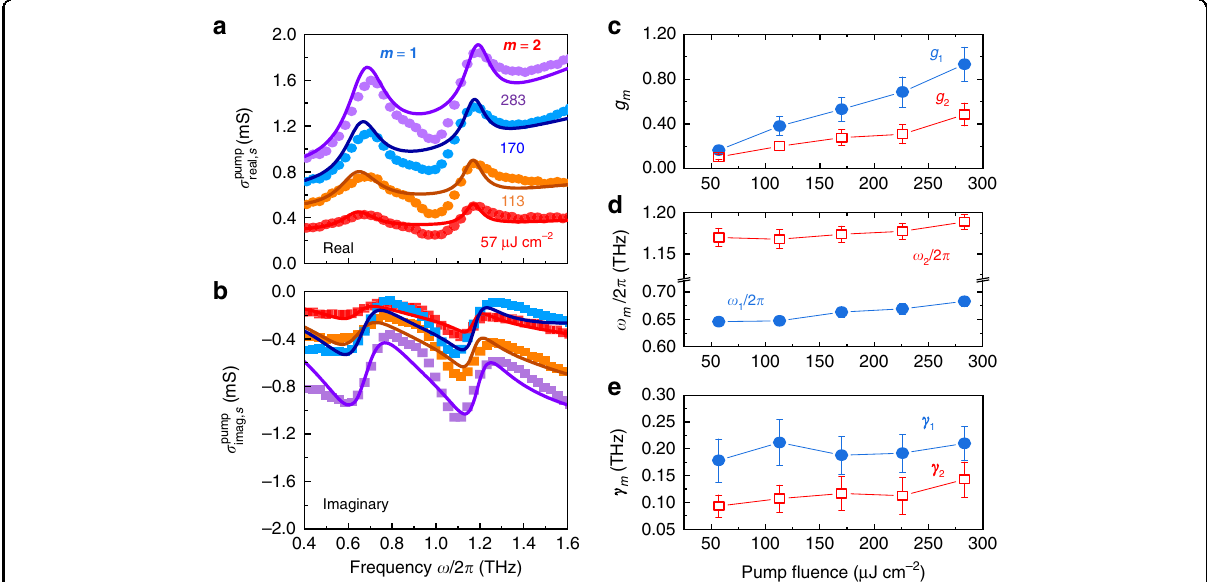
Fig. 3 Pump fl uence-dependent THz photoconductivity spectra for MAPbI 3 polycrystalline grains. Extracted a real and b imaginary parts of THz photoconductivity spectra of MAPbI 3 polycrystalline grains, following photoexcitation at 1.55 eV with pump fl uences of 57, 113, 170, and 283 μ J cm − 2 at 300 K. The solid lines are the DSL model fi ts. Pump fl uence evolutions of c oscillator strength g m , d resonant frequency ω m = 2 π , and e FWHM linewidth γ m of the resonance